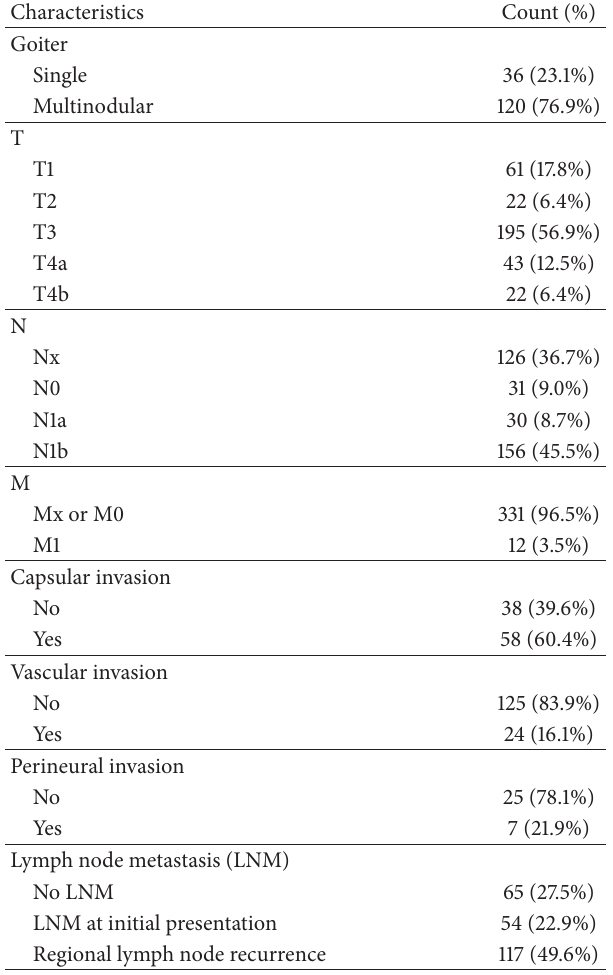
Table 2: Demographic and clinicopathological